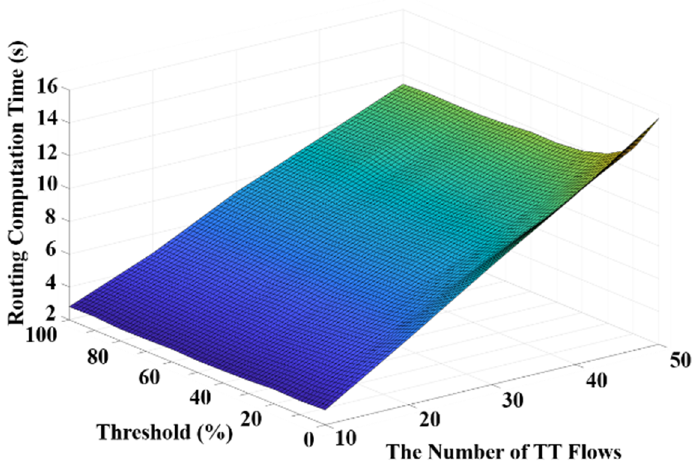
Figure 8. The computation time in routing with thresholds and numbers of flows.